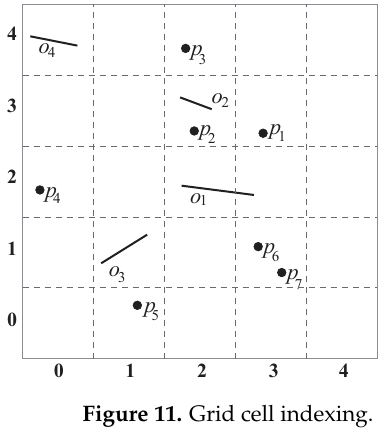
Figure 11. Grid cell indexing.